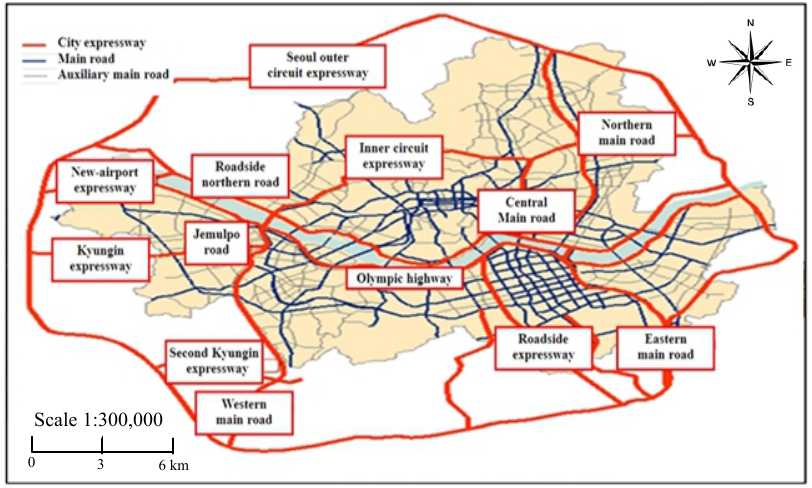
Figure 3. Road networks and sources of road noise in